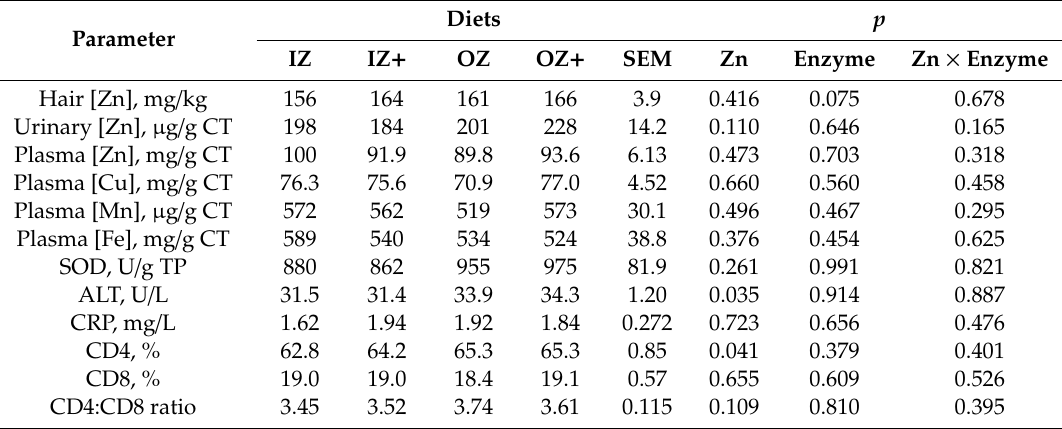
Table 6. Concentration of Zn in hair (mg / kg) and urine ( µ g / g CT), plasmatic concentration of trace elements (unit per g of creatinine, CT), activity of superoxide dismutase (SOD), alanine aminotransferase (ALT), C-reactive protein (CRP) and % of CD4 and CD8 cells of dogs fed the experimental